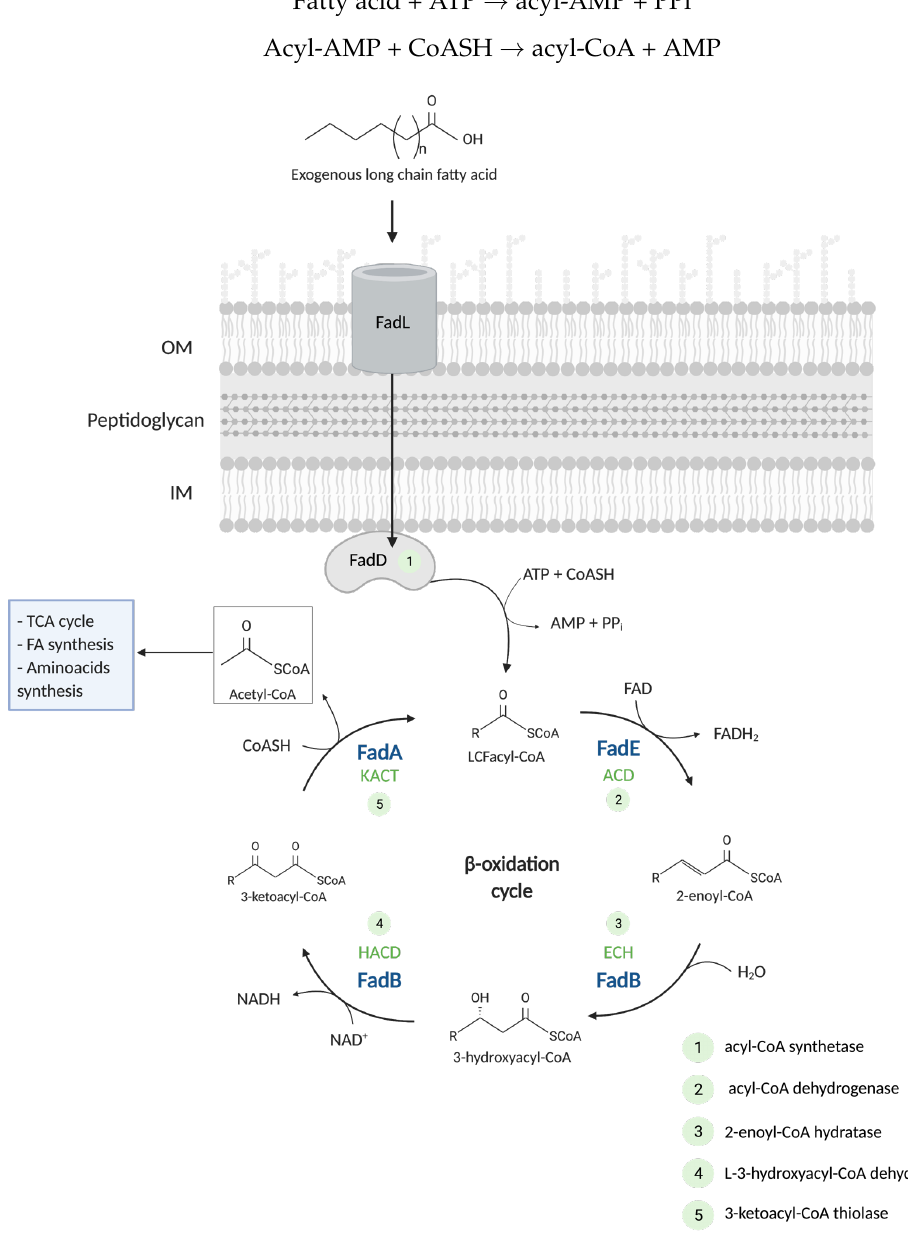
Figure 1. The β -oxidation pathway of fatty acid degradation. Exogenous long-chain fatty acids are imported across the cell membranes via a transport/acyl-activation mechanism involving the outer membrane protein FadL and the inner membrane-bound acyl-CoA synthetase FadD (1). Upon activation, the fatty acyl-CoA enters the β -oxidation cycle. Four enzymatic reactions follow: a first oxidation by FadE, generating one FADH 2 molecule (2, ACD), and three reactions carried out by the tri-functional complex FadBA: a hydration (3, ECH), a second oxidation generating a NADH molecule (4, HACD), and a final thiolytic cleavage (5, KACT), producing a molecule of acetyl-CoA. The acetyl-CoA is the substrate for key metabolic processes of the central metabolism. The enzymes of the β -oxidation cycle are shown in blue. Numbers correspond to the five reactions required for the activation and catabolism of FA. ACD = acyl-CoA dehydrogenase; ECH = enoyl-CoA hydratase; HACD = hydroxy-acyl-CoA dehydrogenase; KACT = ketoacyl-CoA thiolase.